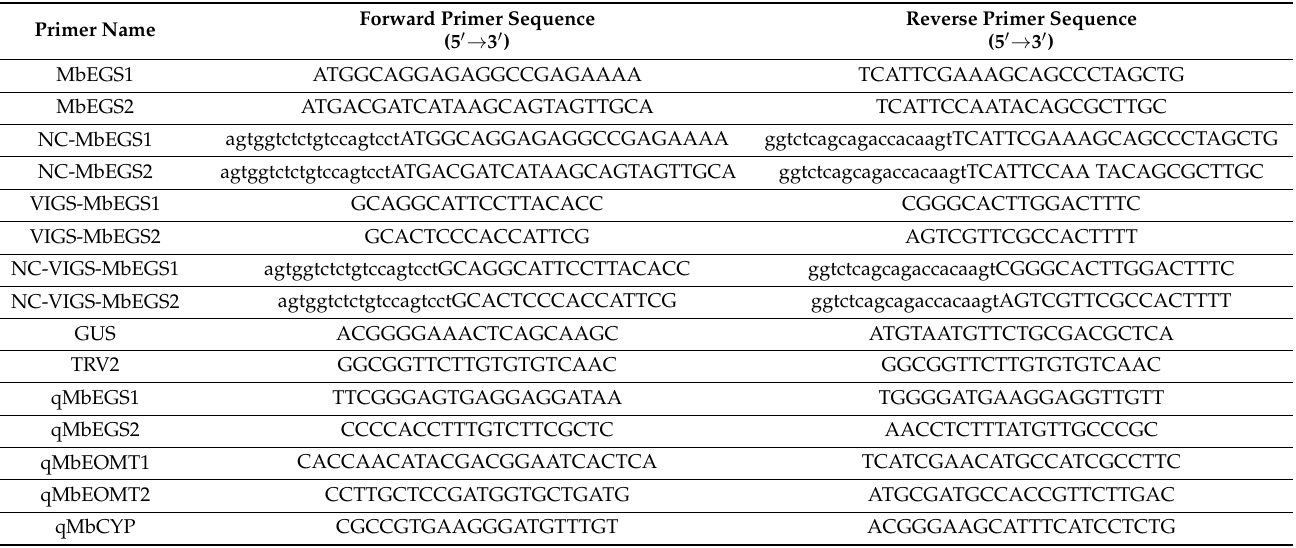
Table 1. List of primers used in this